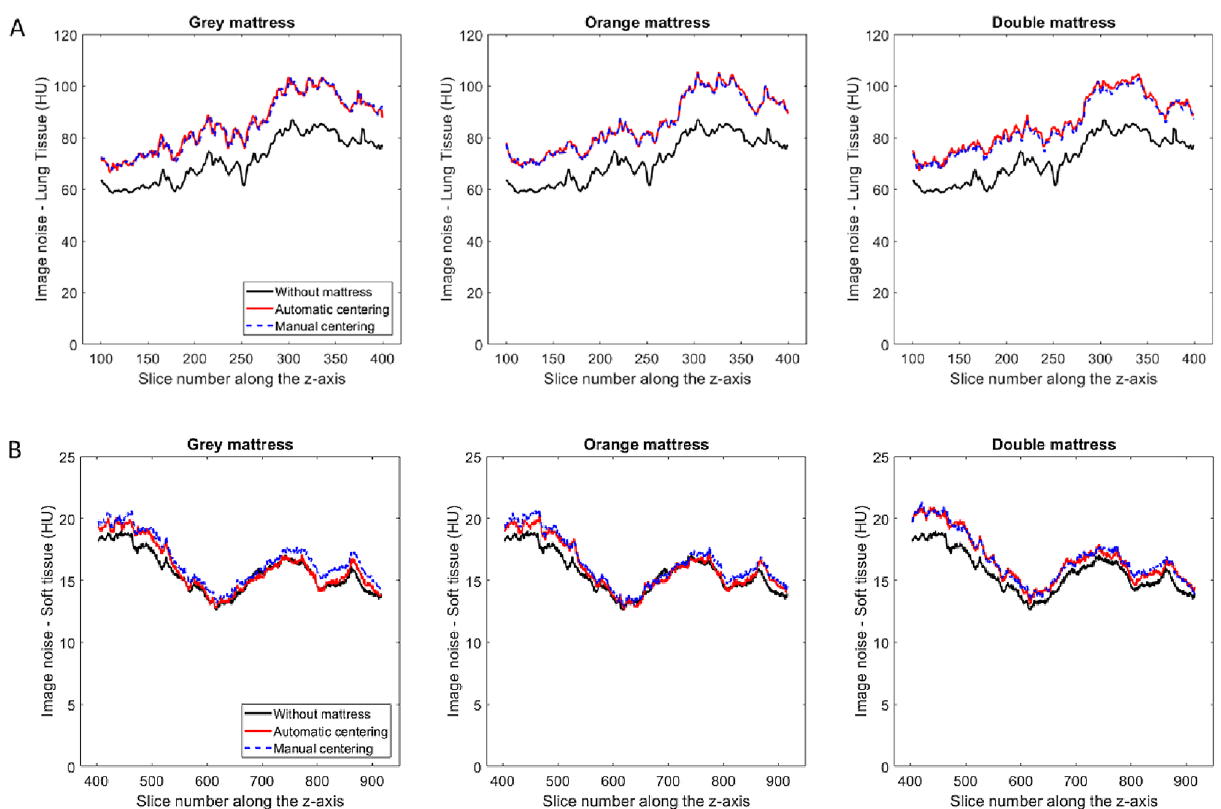
Figure 4. ( a ) Image noise along the z-axis obtained in the lung tissues in the chest area for image acquisitions with additional mattresses after automatic and manual phantom centering. ( b ) Image noise along the z-axis obtained in the soft tissues in the abdomen-pelvis area for image acquisitions with additional mattresses after automatic and manual phantom centering.